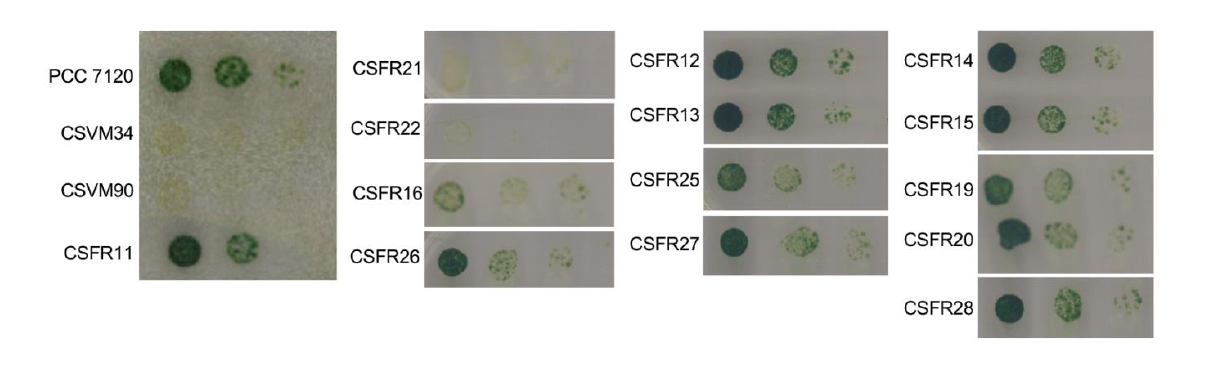
FIGURE 5: Growth test on solid medium of Anabaena and the sepJ mutants. Suspensions of filaments that had been grown in BG11 medium (in the presence of antibiotics for the CSFR mutants) were washed with BG11 0 medium (lacking any source of combined nitro- gen) and resuspended in the same medium. Serial dilutions containing 5, 0.5 and 0.05 ng of Chl were spotted on solid BG11 0 medium, incubated under growth conditions and photographed after 10